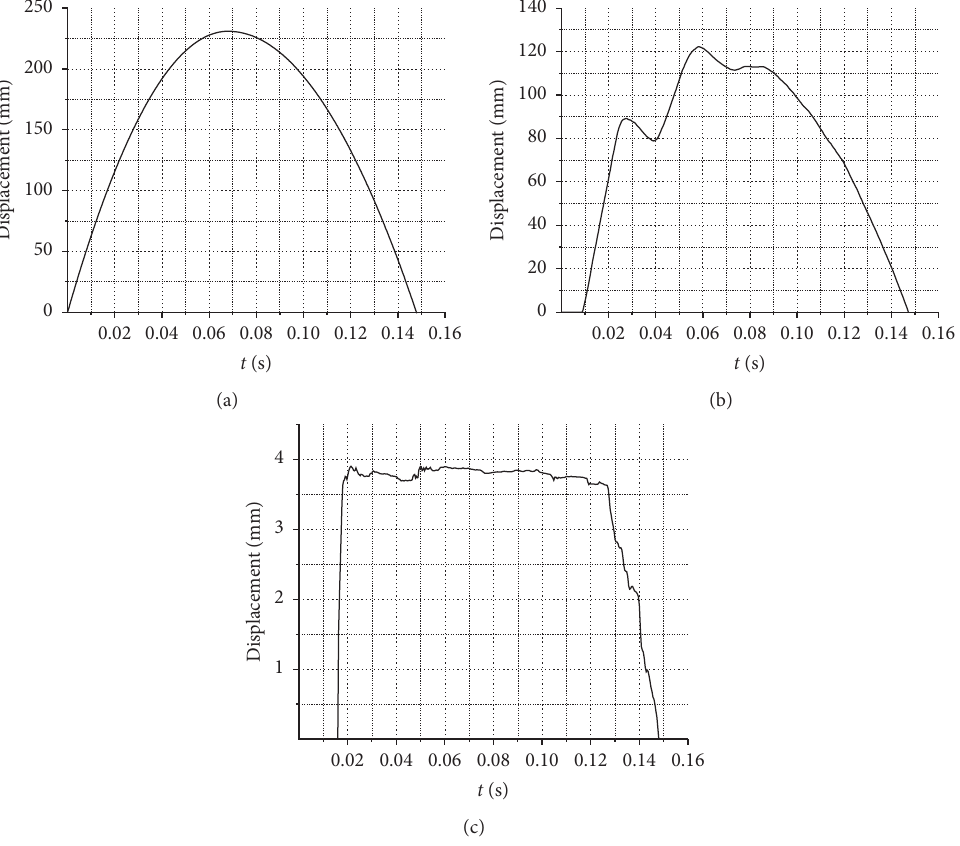
Figure 12: Displacement-time curves of different coils. (a) The 1st coil. (b) The 18th coil. (c) The 35th